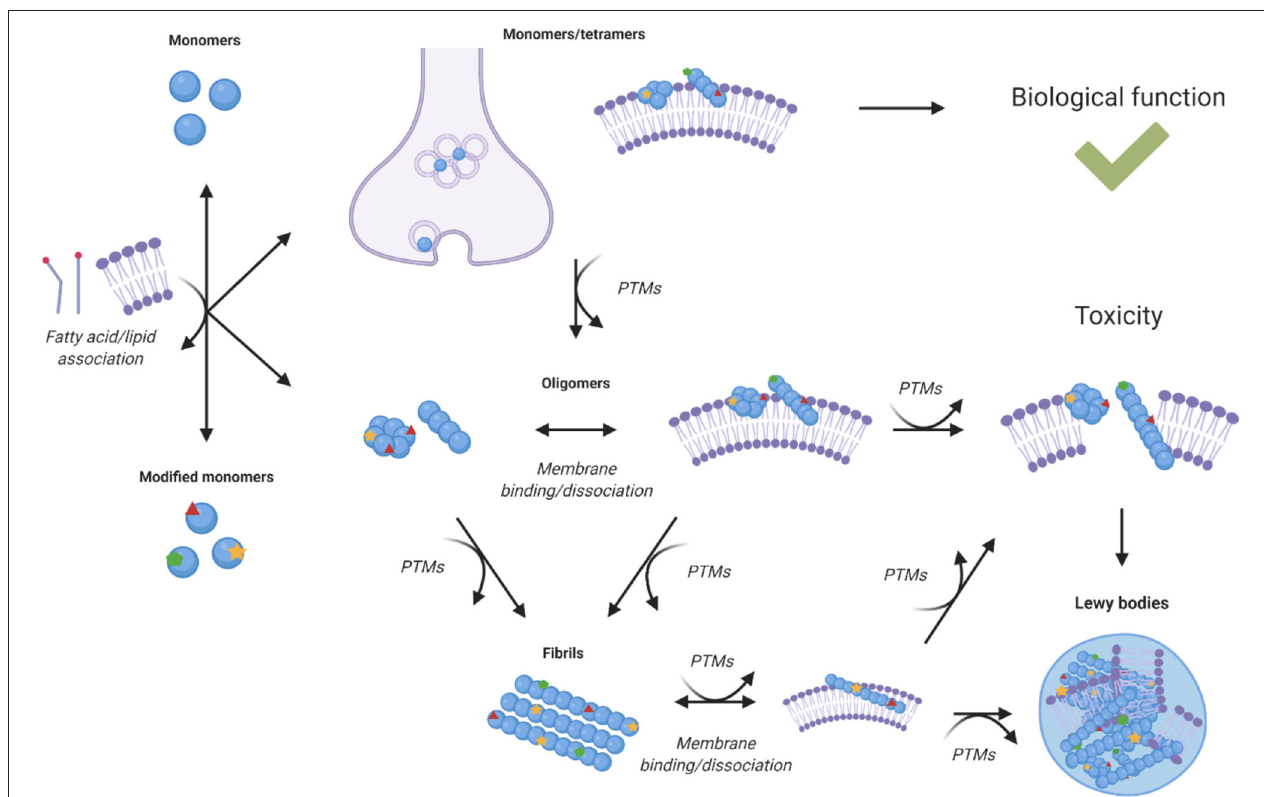
FIGURE 3 | Effects of post-translational modifications on the relationship between α -synuclein homeostasis and lipid homeostasis. Lipid binding is associated with the cellular functions of α -synuclein, but it is also with its toxicity upon aggregation. Different species of α -synuclein can interact with cell membranes, lipid vesicles, and free fatty acids. The interactions of aggregated species of α -synuclein with lipid membranes can lead to altered structure, composition, function, and integrity of the membranes themselves ( 73–75, 77, 84–88, 90, 91). The binding of α -synuclein to lipids and lipid membranes can also impact its aggregation, toxicity, expression, and localisation. Post-translational modifications can alter the interaction of α -synuclein species with lipid species, modulate the binding, and dissociation of α -synuclein with lipid membranes and influence the aggregation propensity of α -synuclein (15, 16, 47, 55, 80–83, 92,